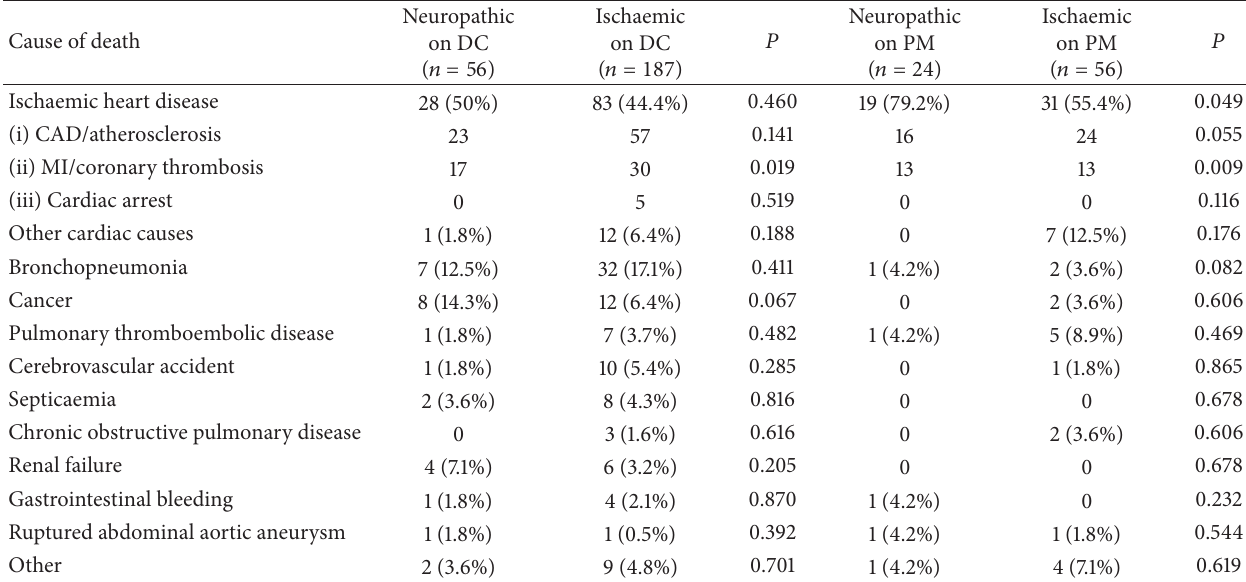
Table 4: Deaths and causes of death in neuropathic and ischaemic ulcer patients on death certification and postmortem examination. Cause of